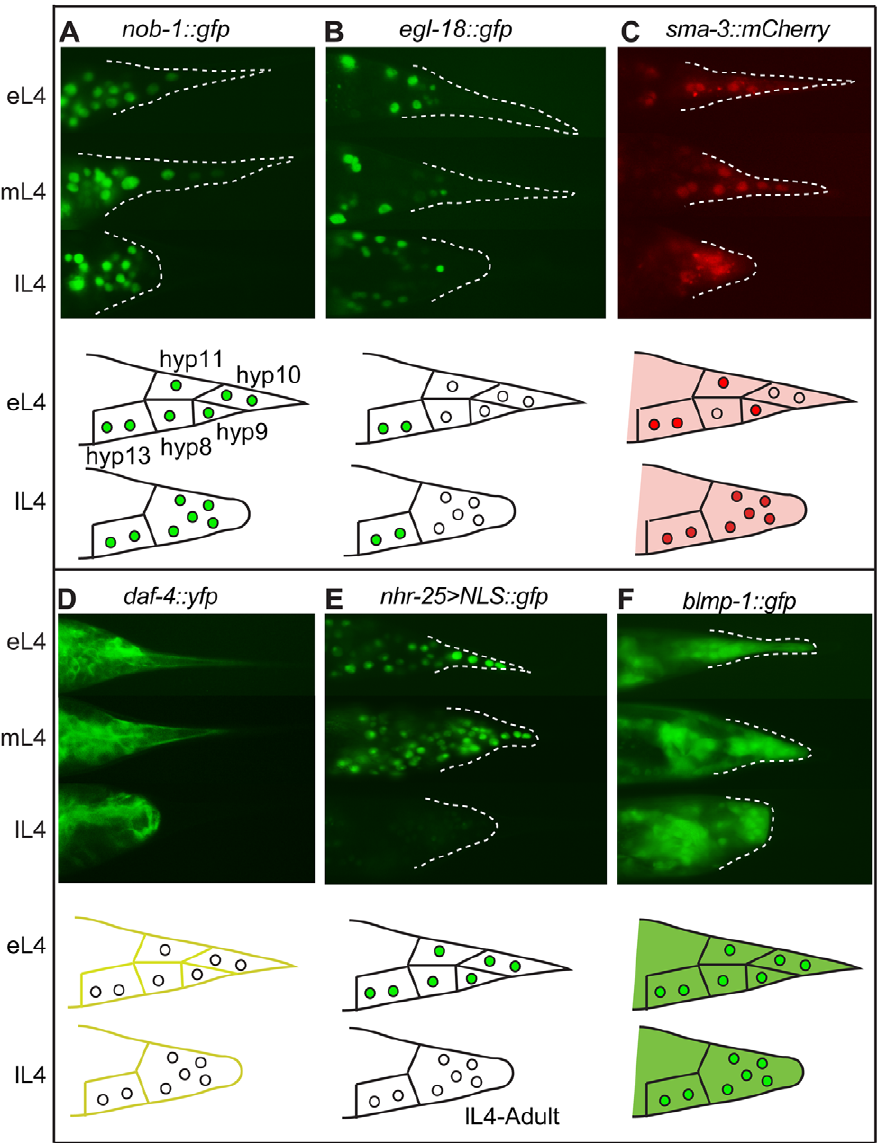
Figure 2. Expression patterns of sample regulatory genes identified in the RNAi screen. Fluorescent micrographs for early, middle and late L4 larvae and schematic drawings for early and late L4 larvae are shown in the upper and lower portions of each panel, respectively. (A) NOB- 1::GFP is expressed in hyp8–11 throughout larval development. (B) EGL-18::GFP is expressed in the male tail but not in hyp8–11. (C) SMA-3::mCherry is cytoplasmic in early L4 and begins to accumulate in the nuclei of the tail tip cells. It then remains nuclear and cytoplasmic throughout tail tip morphogenesis. (D) DAF-4::YFP localizes to the membranes of hyp8–11 prior to and during morphogenesis. (E) An nhr-25 transcriptional reporter shows expression in hyp8–11 at the beginning of morphogenesis, followed by a rapid shutoff. (F) BLMP-1::GFP is expressed in the cytoplasm and nuclei of hyp8–11 throughout larval development.